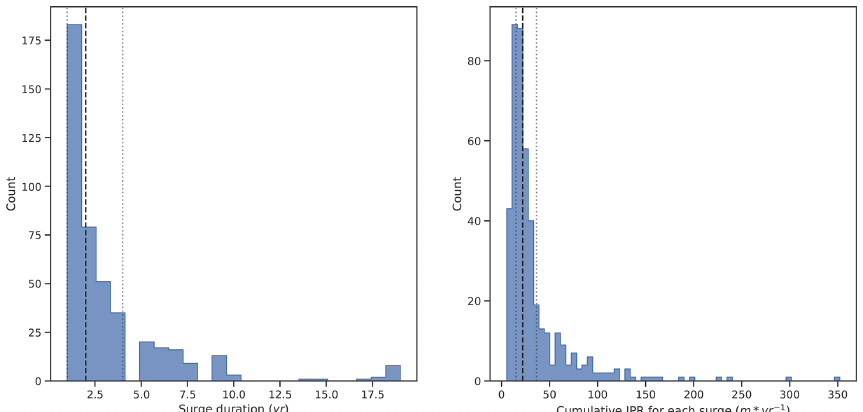
Figure 12. Distributions of surge duration and cumulative sum of IPR for the 439 surges recorded over the 245 glaciers presenting velocity